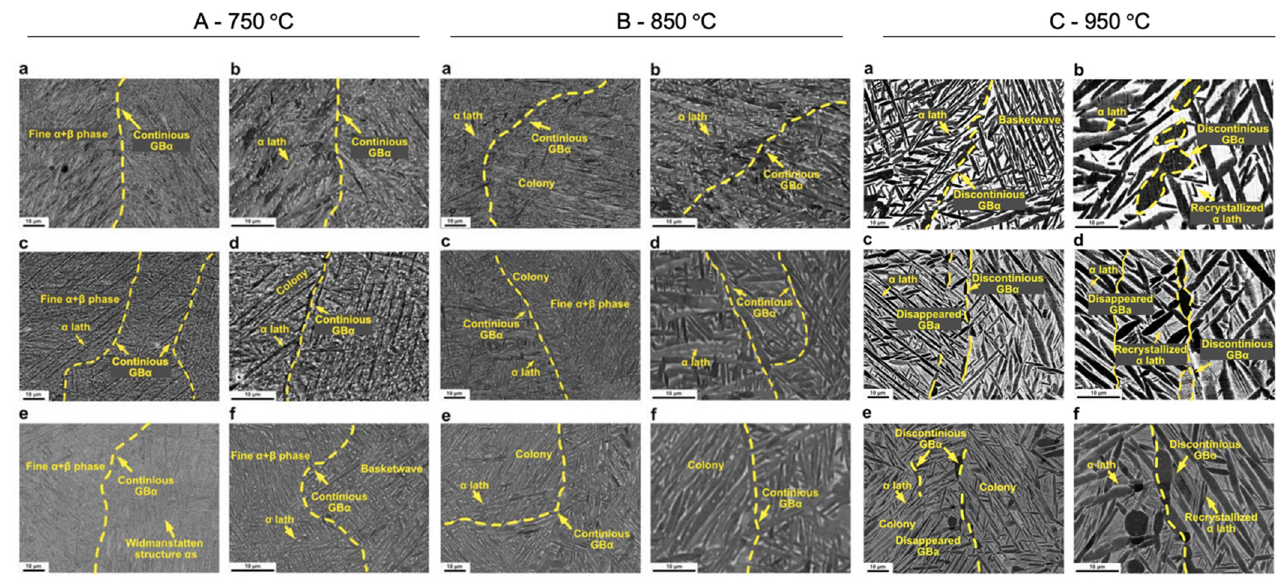
Figure 5. Microstructures of Ti6Al4V parts produced by LPBF with different heat treatments: ( a , b ) heat stage followed by water quenching; ( c , d ) heat stage followed by air cooling; ( e , f ) heat stage followed by furnace cooling (adapted with permission from [5]. Copyright 2021 Emerald Publishing Limited).